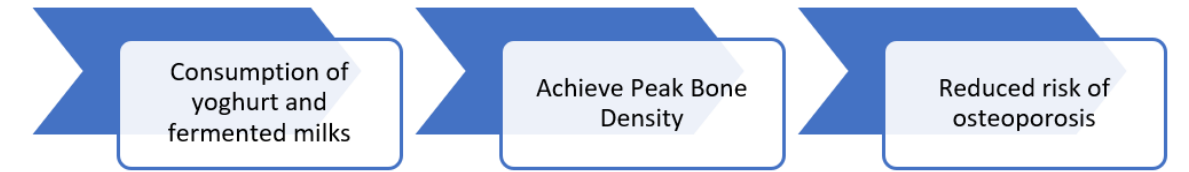
Figure 2. Effect of yoghurts and fermented milks on bone